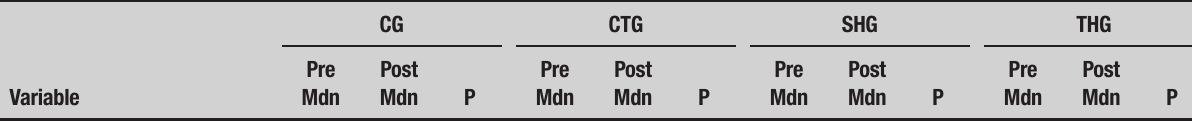
Table 2. Intragroup comparison analysis* – Sleep and cognitive